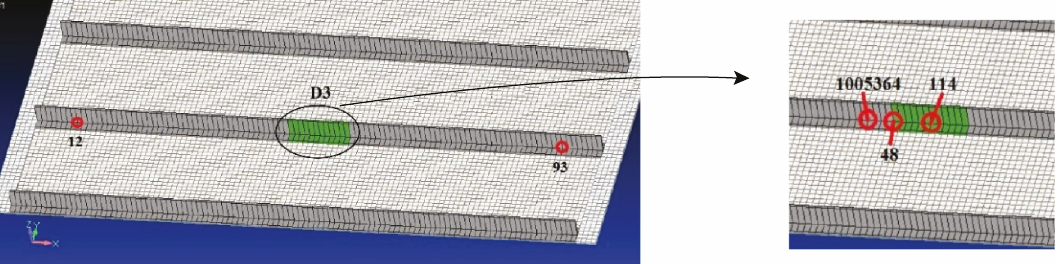
Figure 18: Excitation and measuring nodes for D3 damage along the second sti ff